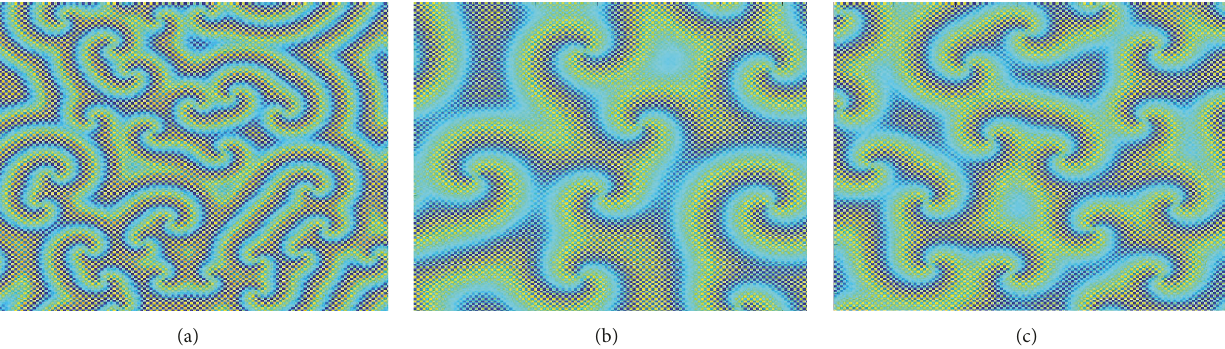
Figure 1: Selective patterns resulting from differentparametersvalues and fixed initial value when 𝑡 = 100000 . (a) 𝑟 = 2.98, 𝑎 = 0.5, 𝐷 = 0.1.